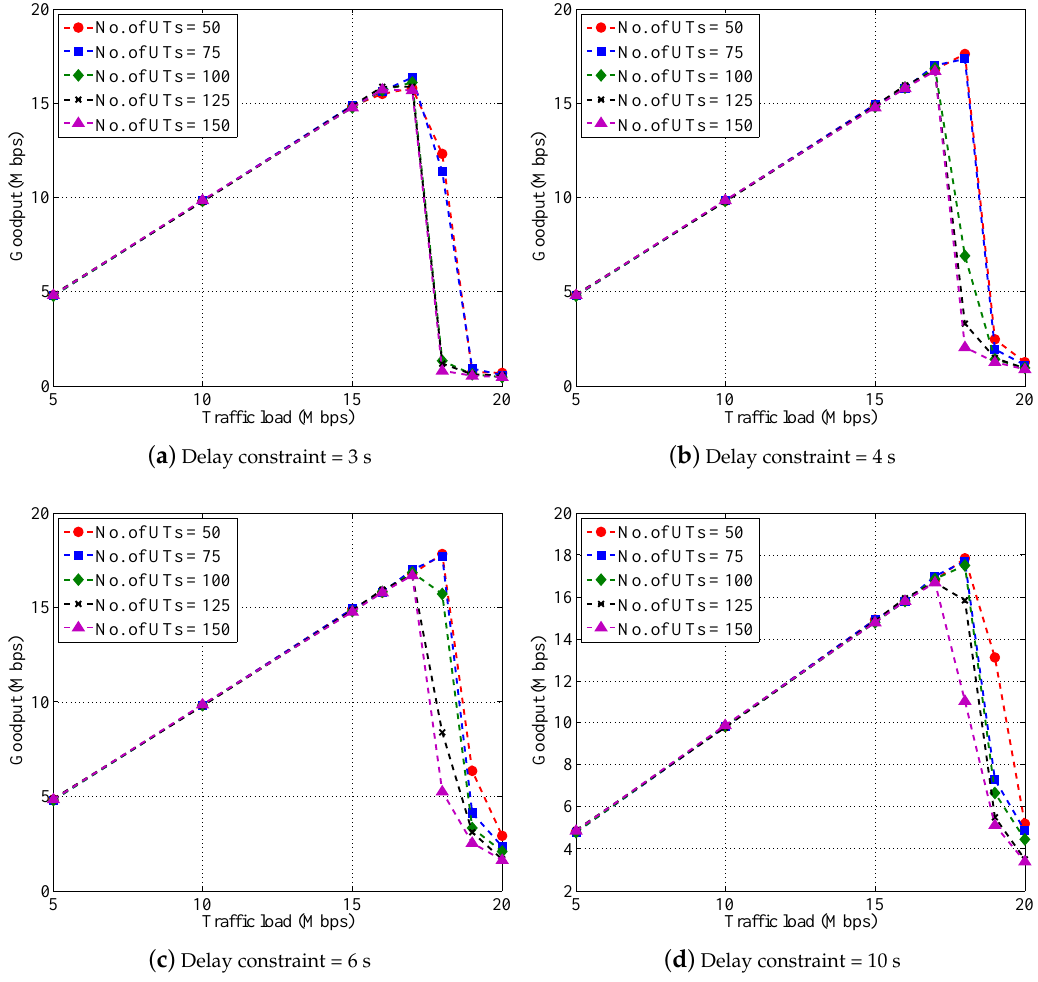
Figure 15. The goodput when the spectral efficiency is 3 bps/Hz when the traffic load varies from 5–20 Mbps and the number of UTs varies from 50–150